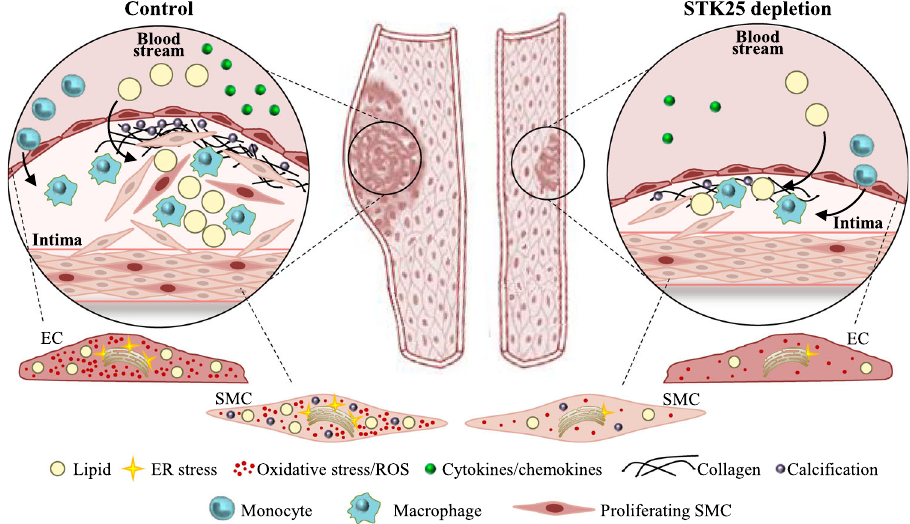
Fig. 8 Schematic illustration of the impact of STK25 in atherosclerosis susceptibility. Silencing of STK25 in human aortic endothelial and smooth muscle cells protects against the atheroprone changes that lead to atherosclerosis development and